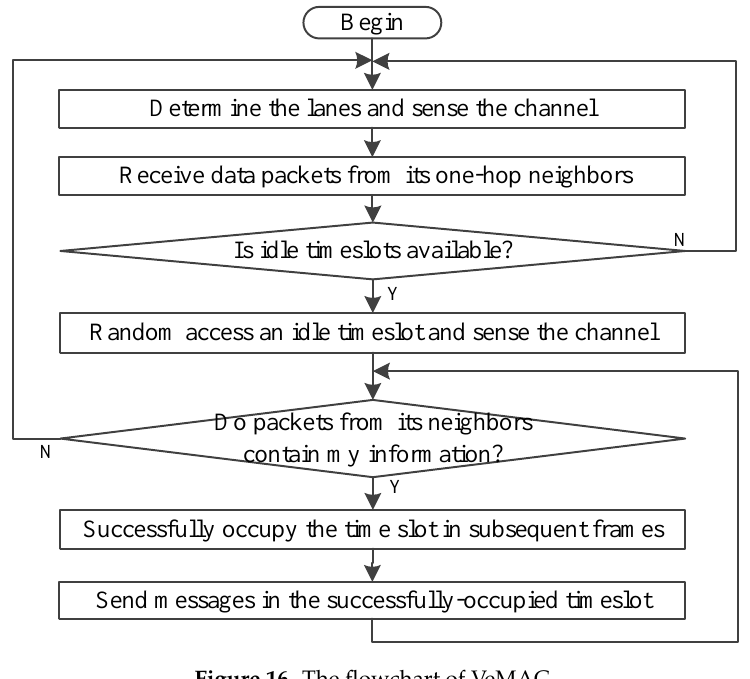
Figure 16. The flowchart of VeMAC.